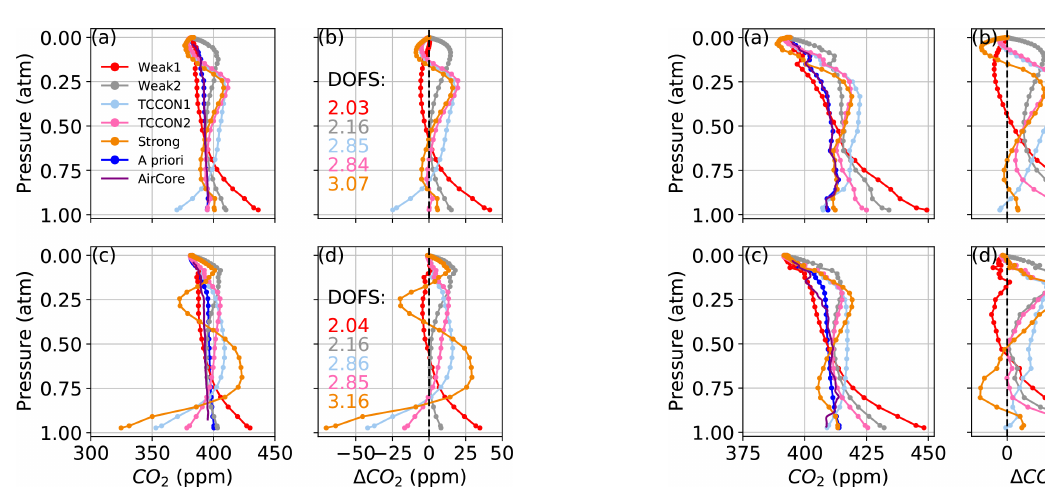
Figure 10. Same as Fig. 9 but for spectra measured on 11 April 2017 at 28–39 ◦ solar zenith